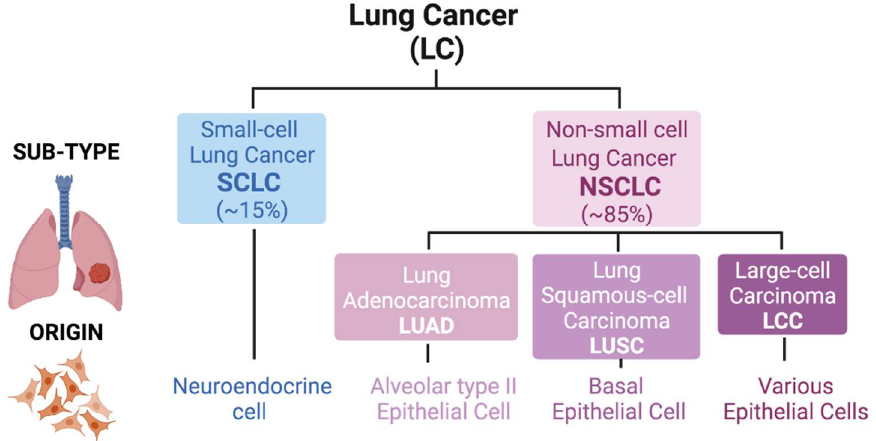
Figure 1. Classification of lung cancer. Lung tumors are divided into two main groups: Small-cell Lung Cancer (SCLC; ≈15% of cases) and Non-small cell Lung Cancer (NSCLC; ≈85% of cases). An SCLC tumor derives from neuroendocrine cell linage. However, in NSCLC, the tumor origin cell is different, being classified into three different sub-types: Adenocarcinoma (LUAD; alveolar type II epithelial cell), Squamous-cell Carcinoma (LUSC; basal epithelial cell) and Large-cell Carcinoma (LCC; various epithelial cells).